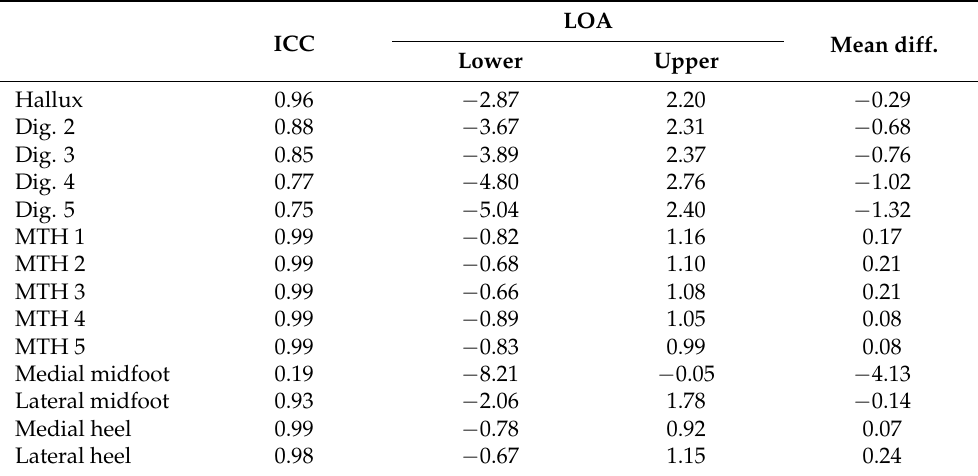
Table 2. Agreement between platform and handheld thermometer assessments of foot temperature for 14 plantar foot